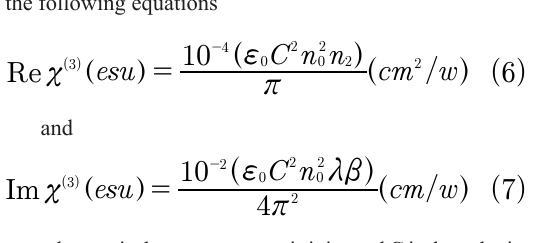
Table 1: Results of the z-scan technique. Non-linear refractive index (n